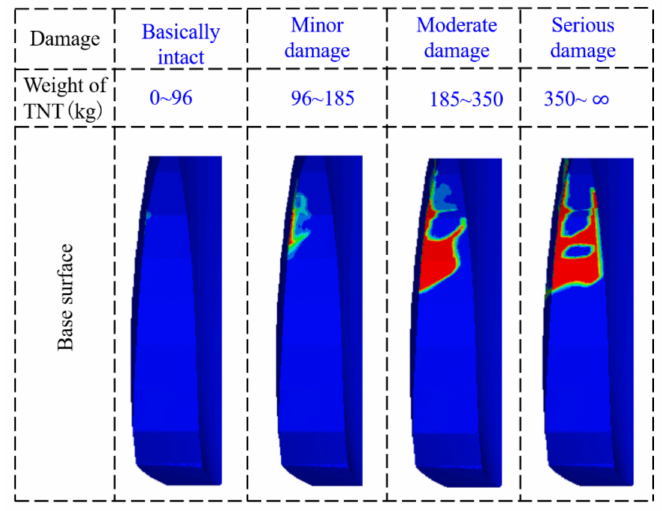
Figure 13. The degree of damage to the abutment for different masses of